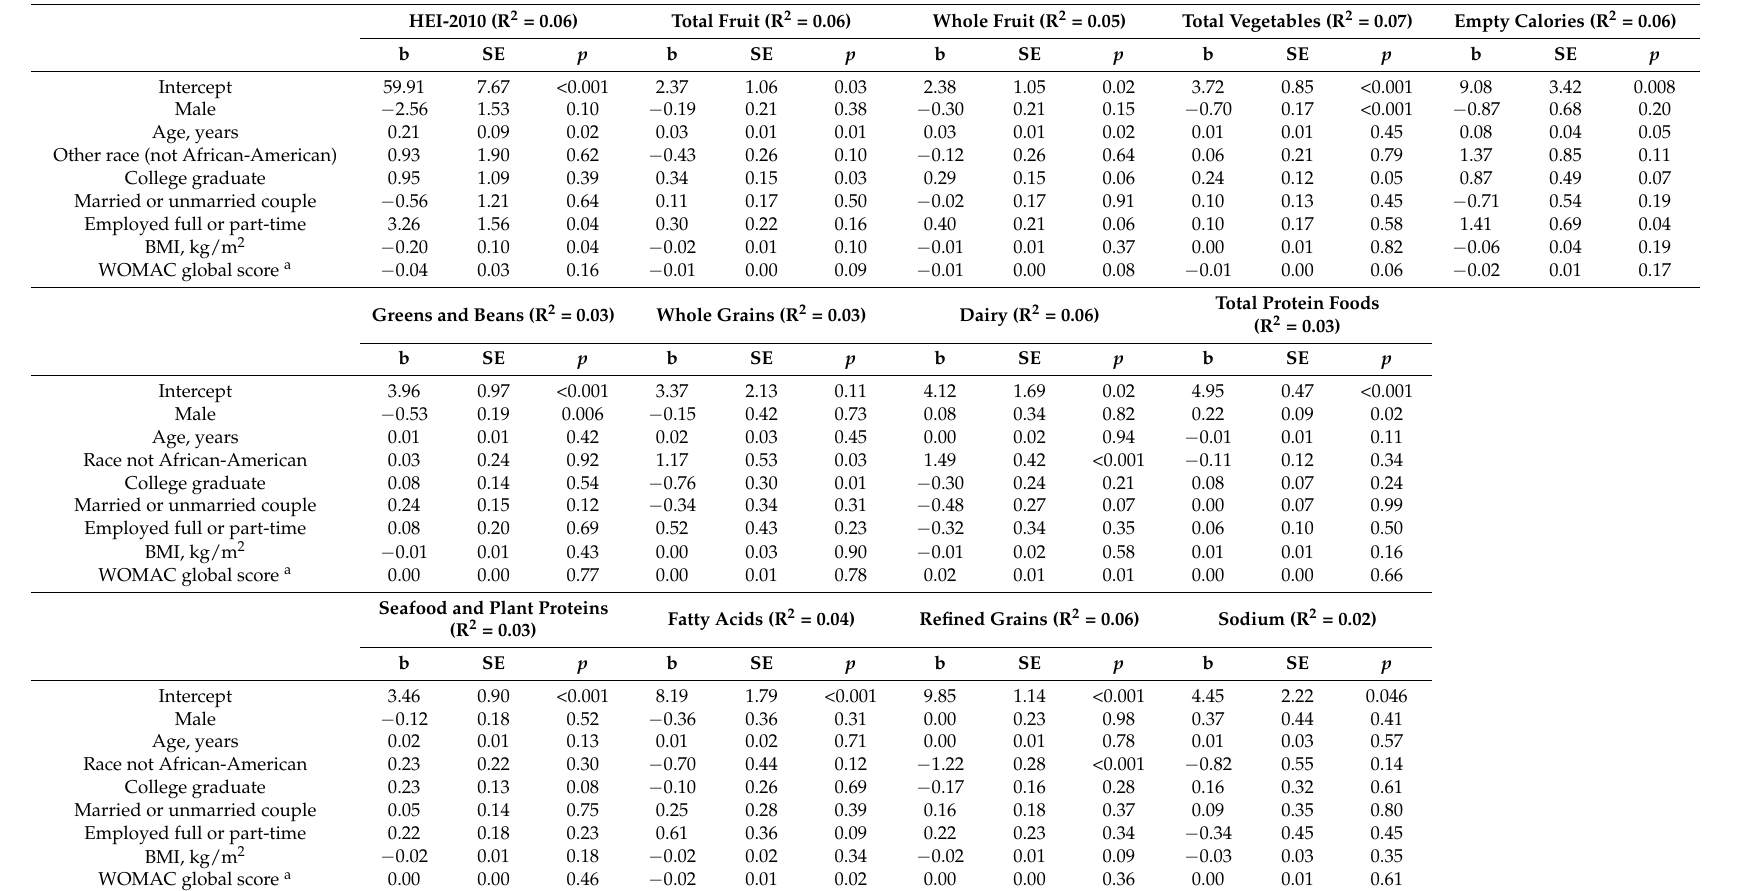
Table 5. Predictors of Healthy Eating Index-2010 (HEI-2010) total and component scores in urban overweight and obese primarily African American older adults with